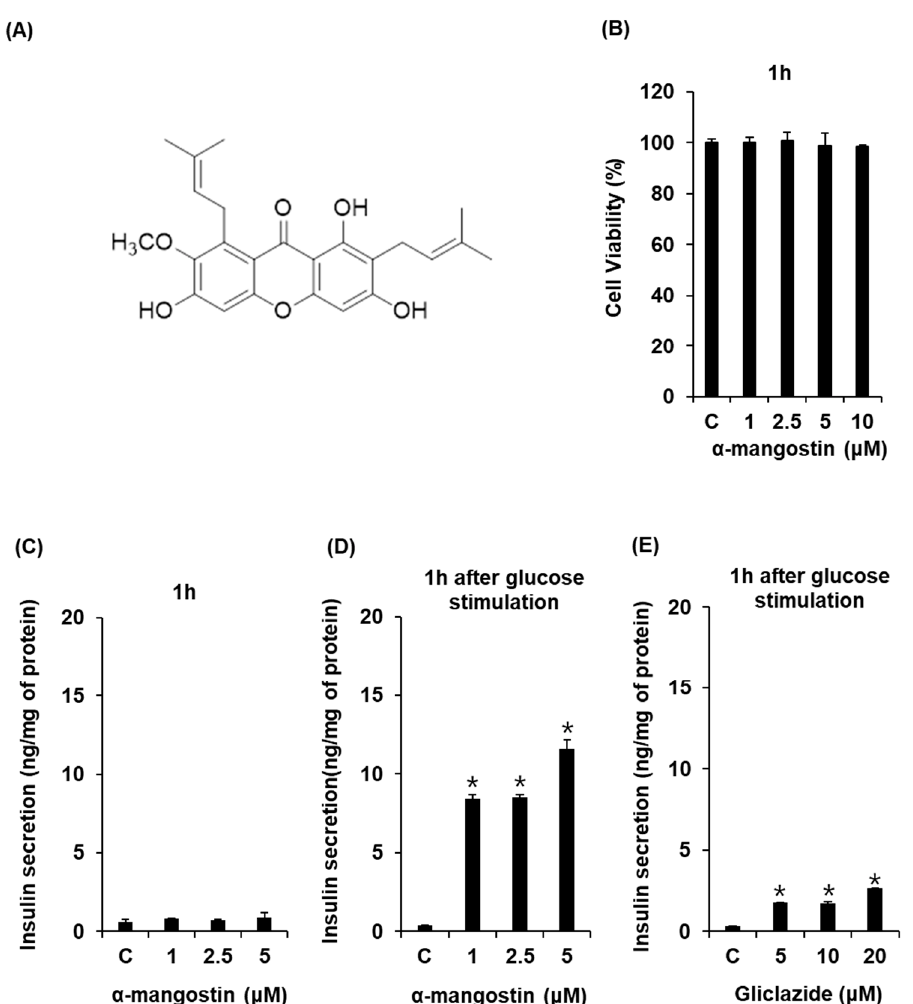
Figure 1. Effect of α -mangostin on glucose-stimulated insulin secretion (GSIS) in INS-1 cells. ( A ) Structure of α -mangostin. ( B ) Effect of α -mangostin on viability of INS-1 cells for 1 h. ( C ) Effect of α -mangostin on insulin secretion in INS-1 cells for 1 h in the absence of glucose. ( D ) Effect of α -mangostin on glucose-stimulated insulin secretion in INS-1 cells for 1 h. ( E ) Effect of gliclazide (positive control) on glucose-stimulated insulin secretion in INS-1 cells for 1 h. Insulin amount was normalized by total protein amount in the cell lysates. * p < 0.05 compared to the control value.